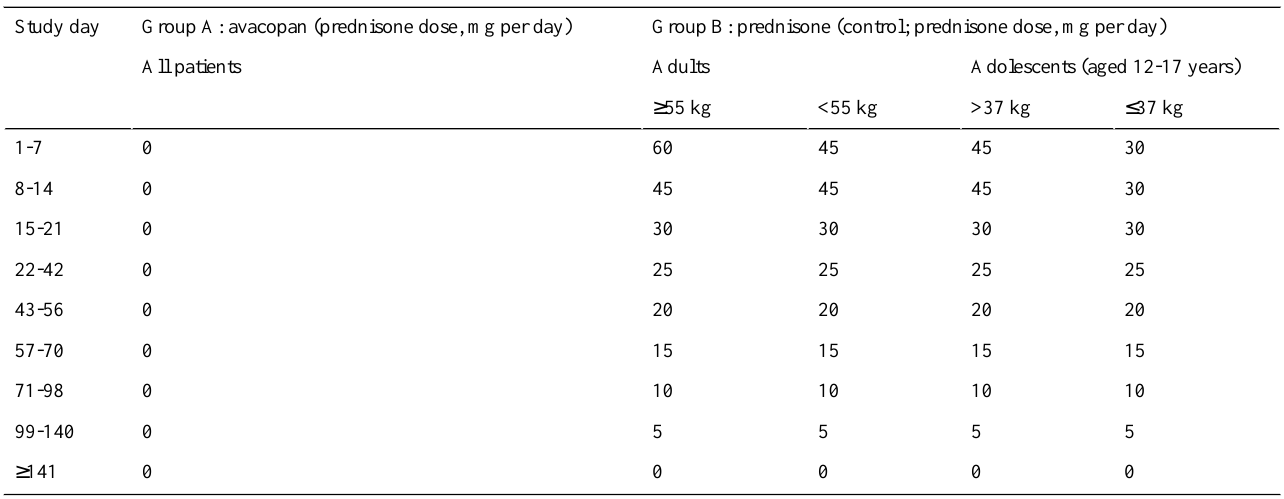
Table 1. Glucocorticoid and matching placebo tapering